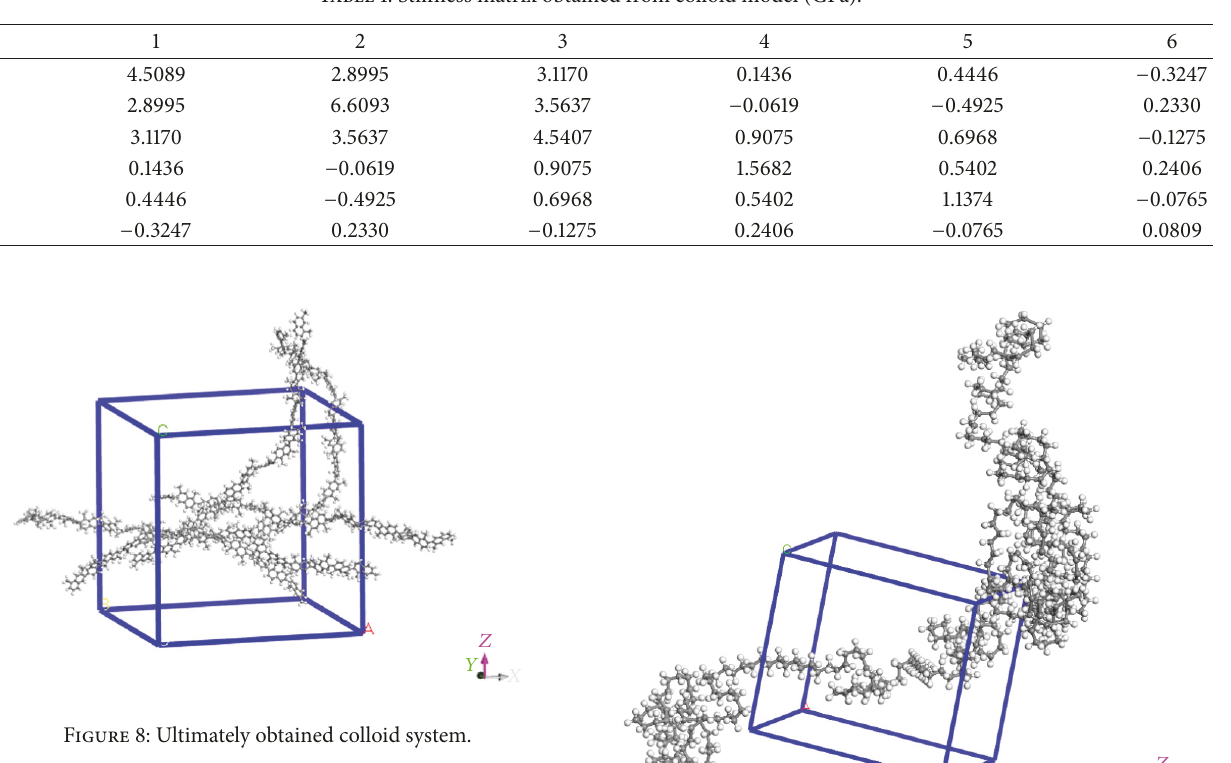
Table 1: Stiffness matrix obtained from colloid model (GPa).